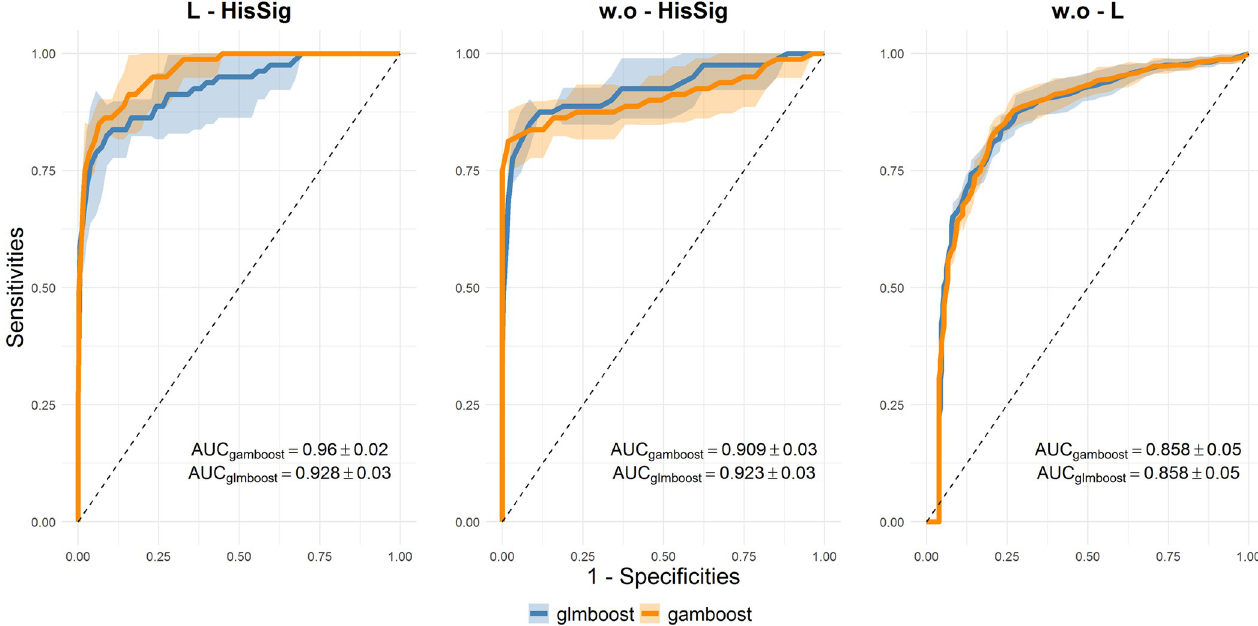
Fig 5. Averaged ROC curves of the prediction performance glmboost (blue) and gamboost (orange). The averaged ROC curves were estimated based on 40 subsamples generated by the repeated stratified 4-fold cross-validation in the three comparisons of the FaPaCa sample. The shaded areas represent the one standard deviation intervals. At the right bottom corner, the average AUCs and their standard deviations are